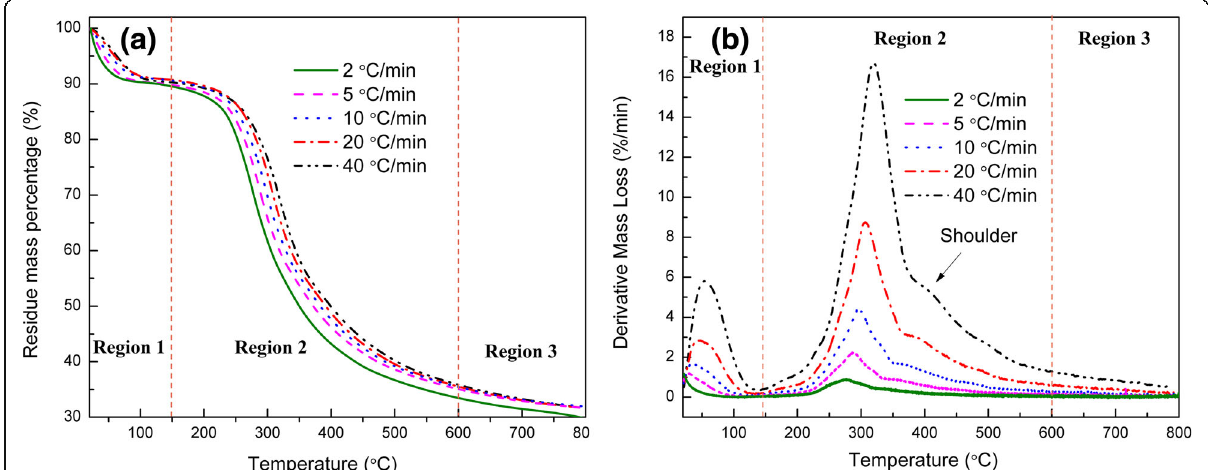
Fig. 1 ( a ) TG and ( b ) DTG curves of vegetable-tanned leather